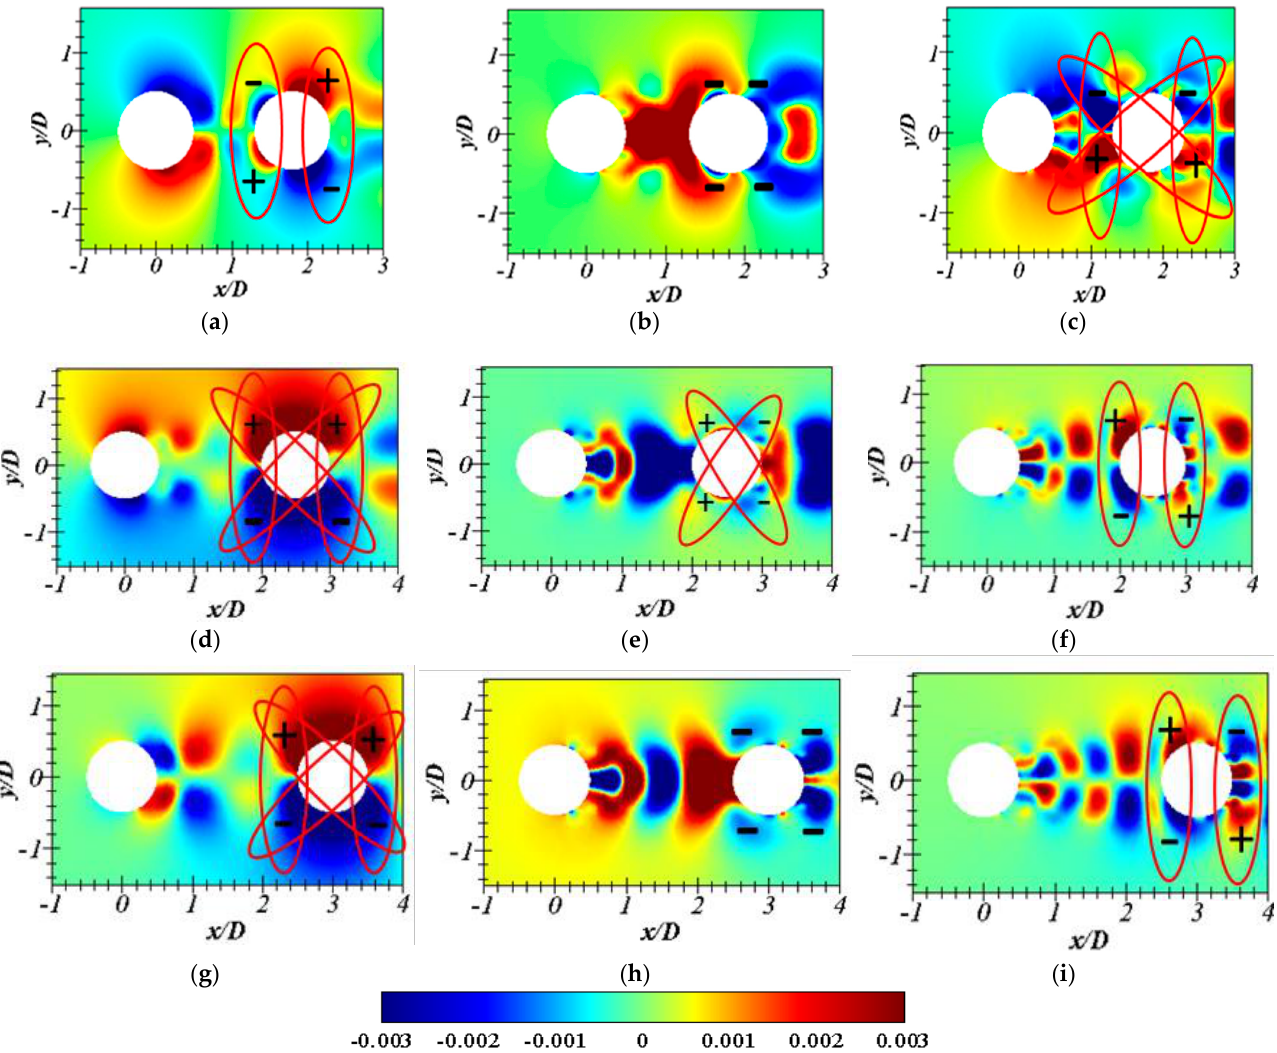
Figure 19. The spatial structures of the pressure of Mode 1, Mode 2 and Mode 3 for 𝐿/𝐷 = 1.8,2.5 and 3 : ( a ) Mode 1, 𝐿/𝐷 = 1.8 , ( b ) Mode 2, 𝐿/𝐷 = 1.8 , ( c ) Mode 3, 𝐿/𝐷 = 1.8 ; ( d ) Mode 1, 𝐿/𝐷 = 2.5 , ( e ) Mode 2, 𝐿/𝐷 = 2.5 , ( f ) Mode 3, 𝐿/𝐷 = 2.5 , ( g ) Mode 1, 𝐿/𝐷 = 3 , ( h ) Mode 2, 𝐿/𝐷 = 3 , ( i ) Mode 3, 𝐿/𝐷 = 3 .